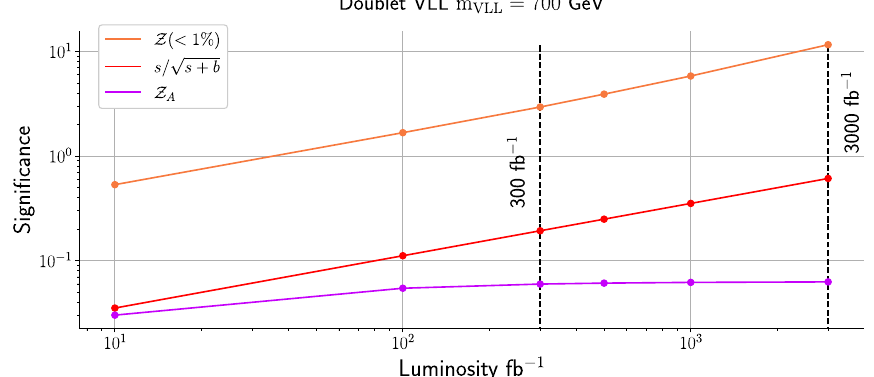
network that the evolution algorithm found. From left to right we plot √ s + b in a , the adapted Asimov significance where the significance s / we assume a background uncertainty of 10 − 3 in b , and the Asimov significance with systematics of 1% in c